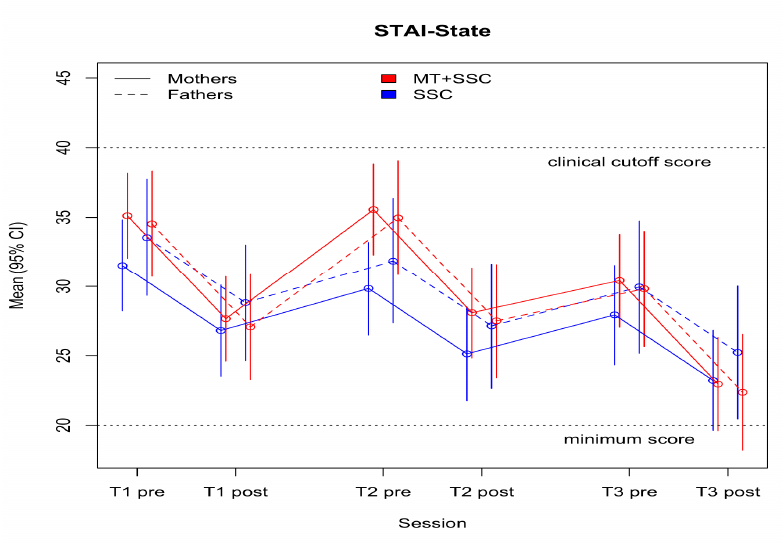
Figure 3. Parental state-anxiety measures across all